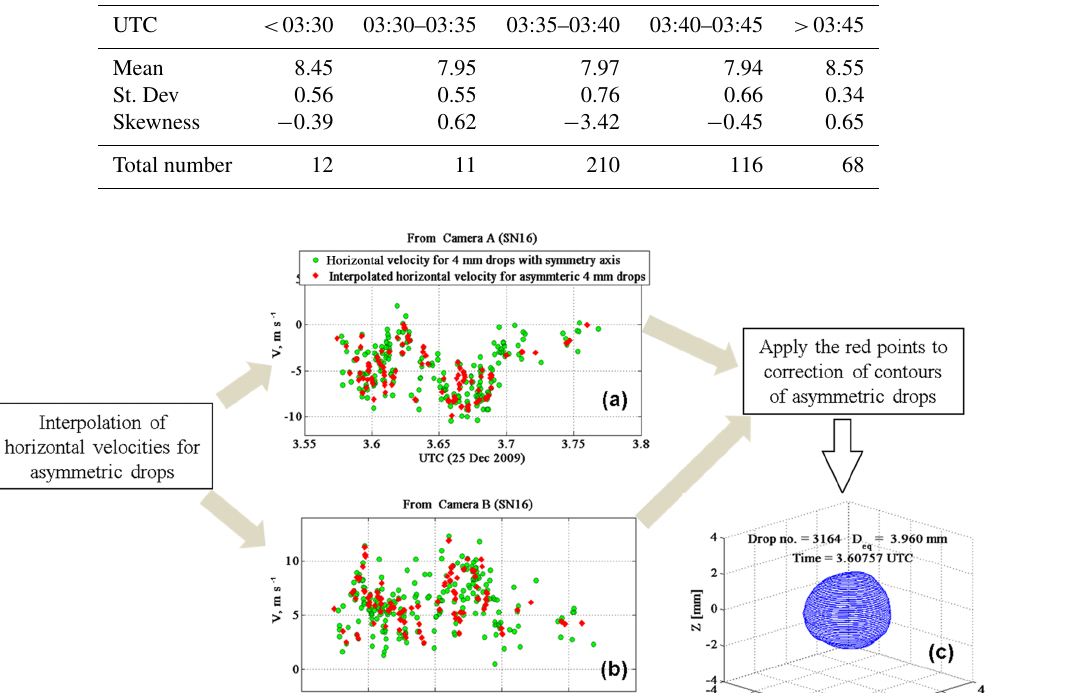
Table 1. Mean, standard deviation, and the skewness of the histograms of these fall velocities for various time periods corresponding to Fig. 1, namely, (i) prior to 03:30UTC, (ii) 03:30–03:35UTC, (iii) 03:35–03:40UTC, (iv) 03:40–03:45UTC, and (v) after 03:45UTC. Also shown are the total numbers of the 4mm drops during these time intervals.